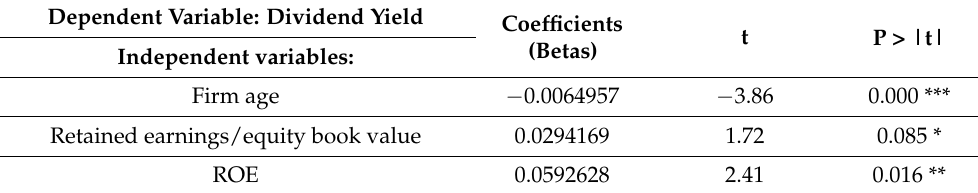
Table 4. Empirical results using dividend yield and the second proxy of leverage. This regression used the fixed effect model. Significant results are followed by one asterisk * if the statistical test is significant with α = 10%; two asterisks ** if the statistical test is significant with α = 5%; and three asterisks *** if the statistical test is significant with α = 1%. The independent variables are firm age (number of years since the creation date of the firm), retained earnings/equity book value, profitability (ROE), leverage using total